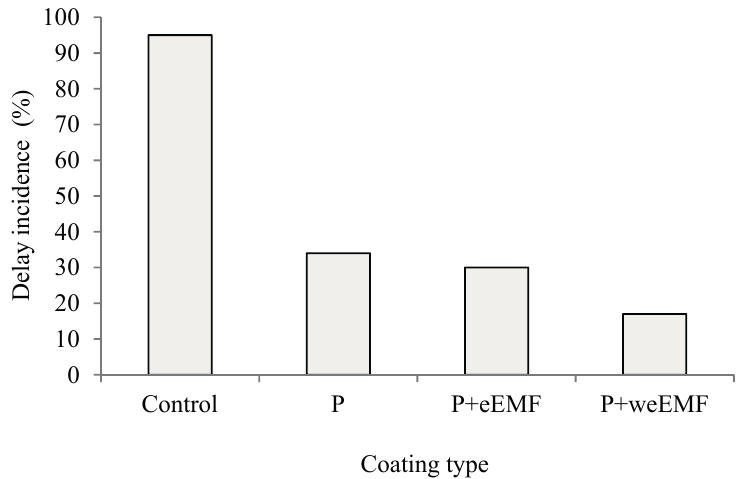
Figure 1. Effect of pullulan coating with or without incorporated meadowsweet flower extract on delay incidence of peppers inoculated with R. arrhizus spores after 5 days at simulated marketing conditions (24 °C, RH 55%–60%). The incidence of decay was expressed as a percentage of the peppers exhibiting disease